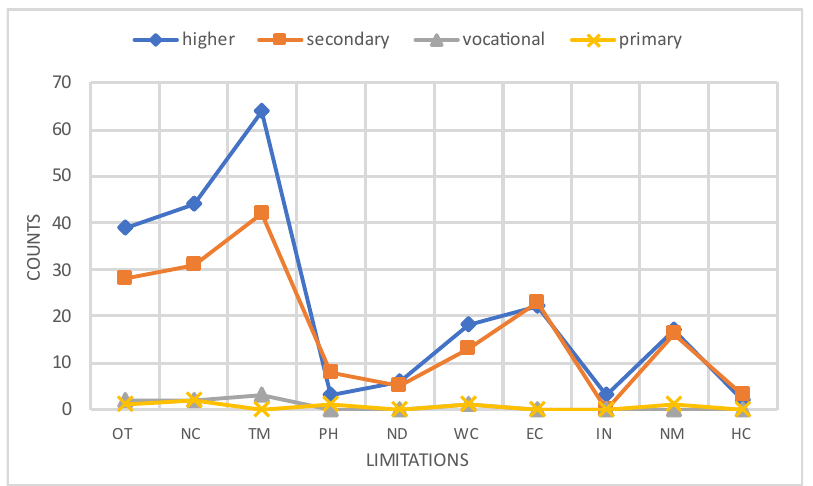
Figure 32. A graph of the interaction between limitations in the availability of tram transport and education.